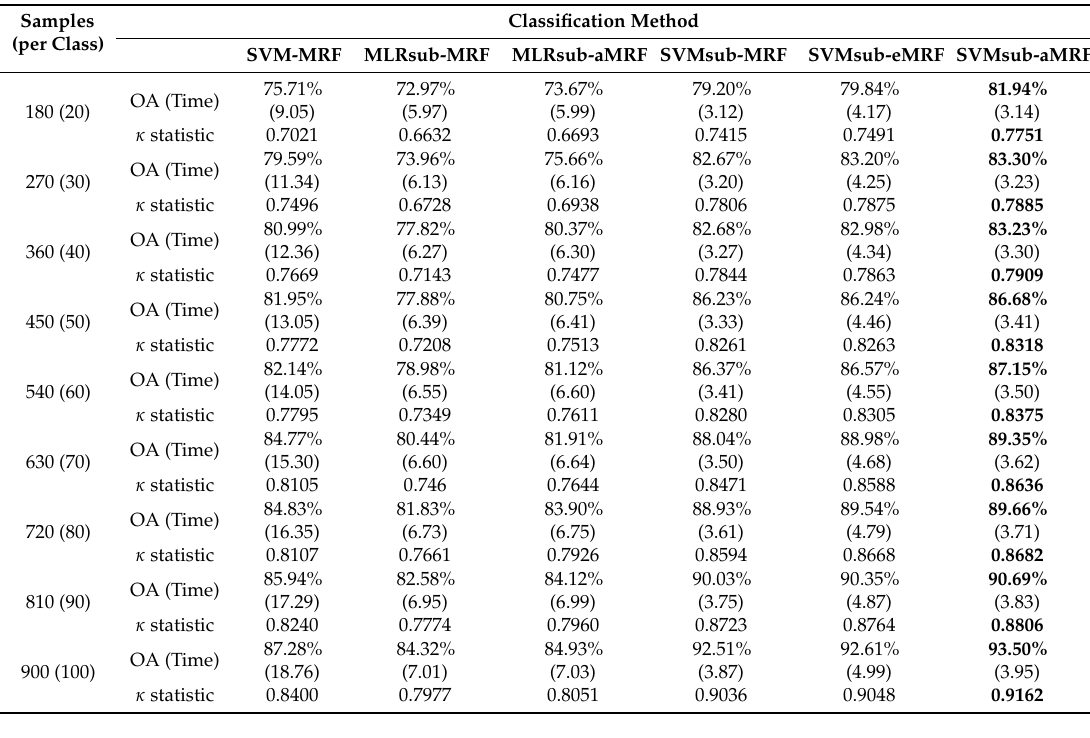
Table 5. Overall classification accuracies (in percent) and κ statistic values obtained by the various tested methods for the ROSIS University of Pavia data set scene using different numbers of training samples. The computational costs (in parentheses) are also presented. Both the total number of samples used and the (approximate) number of training samples per class (in parentheses) are shown.